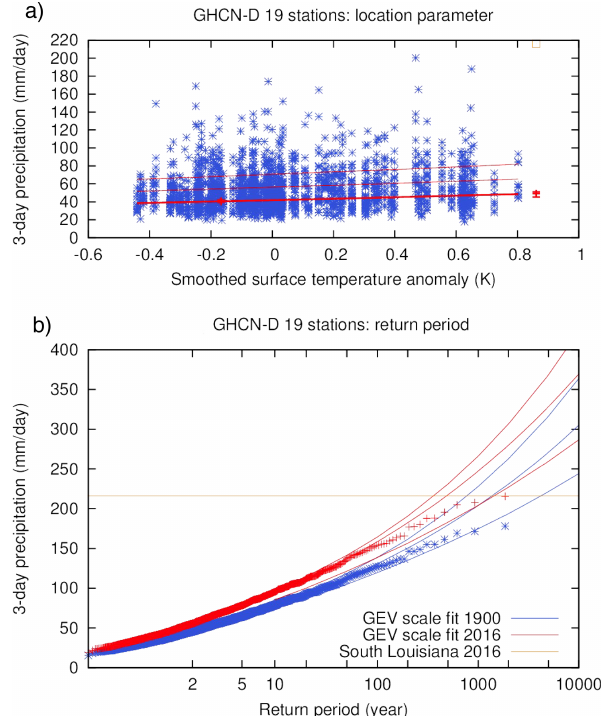
Figure 6. Similar to Fig. 5 but for the extreme precipitation event in southern Louisiana in August 2016, using a GEV distribution that scales with GMST and evaluated for the years 1900 and 2016. Reproduced from van der Wiel et al. (2017) under the licence agree- ment at https://creativecommons.org/licenses/by/4.0/ (last access: 31 October 2018); see original paper for more